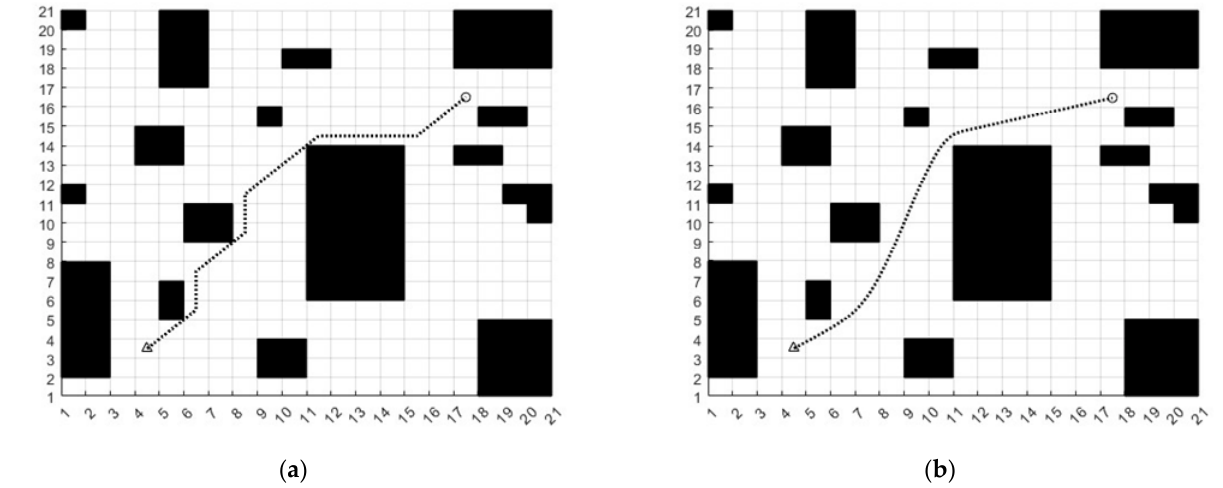
DWA algorithm, a 21 m × 21 m raster map is selected for the experiment. A movable ob- 9.